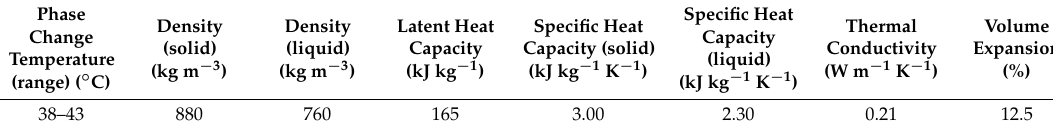
Figure 1. ( a ) Schematic of the simulated system (not in scale, in millimeters); ( b ) enthalpy–temperature curve for the paraffin used in the simulations for type validation. Table 1. Main thermo-physical properties of the paraffin RT40.